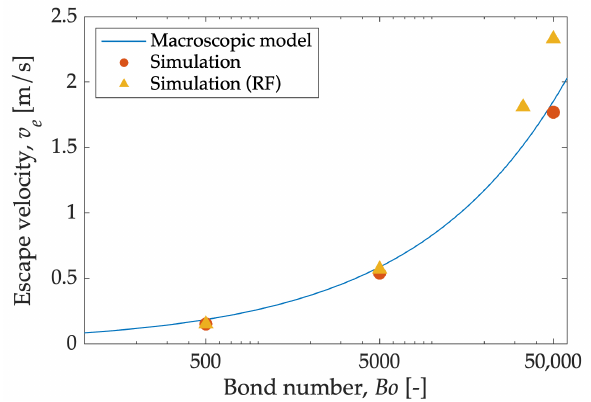
Figure 9. Escape velocity as a function of Bond number calculated by the macroscopic analytical model and compared to DEM simulations with and without rolling friction (RF).